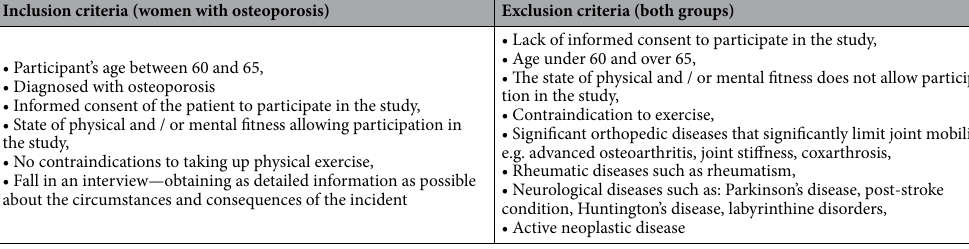
Table 1. Inclusion and exclusion